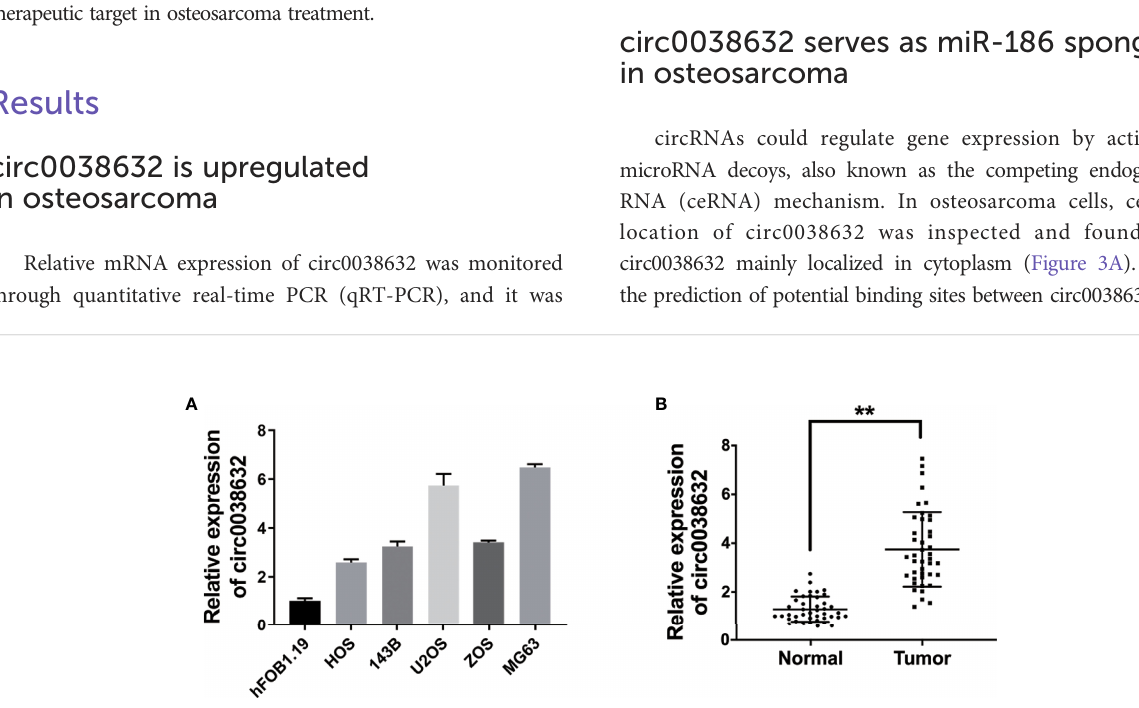
FIGURE 1 circ0038632 is upregulated in osteosarcoma. (A) The circ0038632 expression in osteosarcoma cell lines. (B) The circ0038632 expression in 42 pairs of osteosarcoma tissues and adjacent normal tissues. ** P <